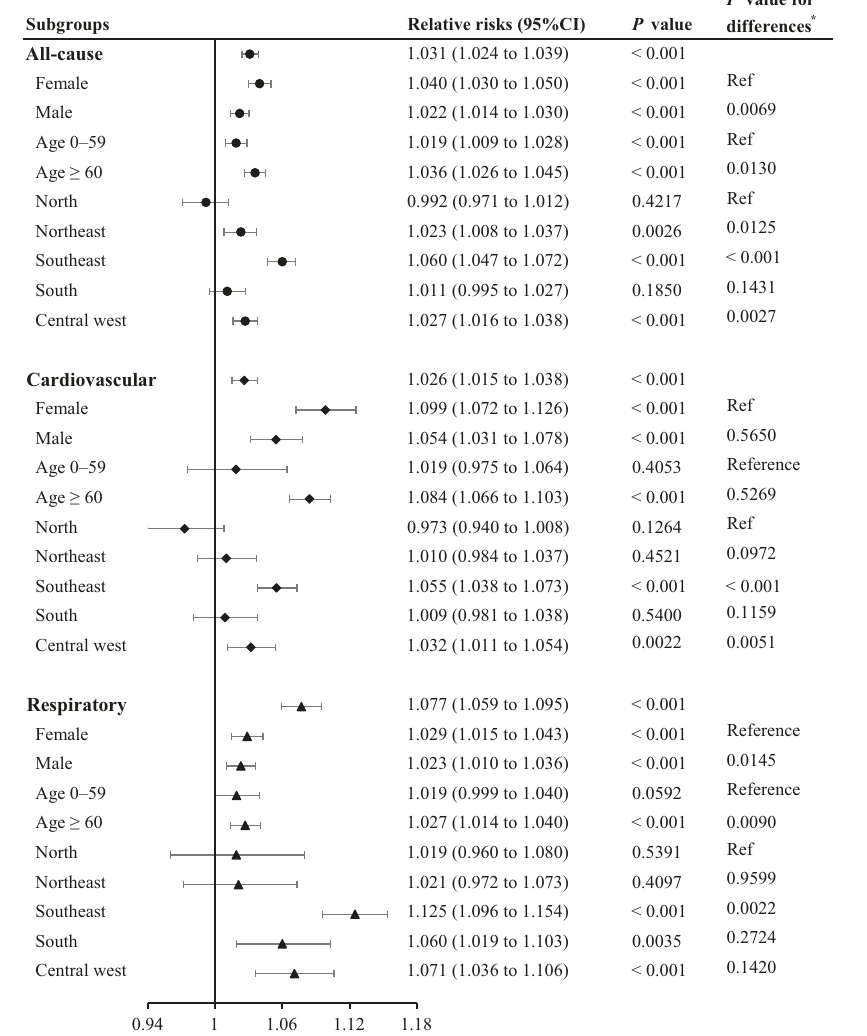
Fig. 3 | Pooled relative risks of all-cause, cardiovascular, and respiratory mor- tality (strati fi ed by sex and age groups) associated with a 10 µ g/m 3 increase in wild fi re-related PM 2.5 over lag 0 ‒ 14 days. (Note 1: * p value for the differences in cumulativerelativerisks(with95%CI)acrosspopulationsubgroupswereestimated by fi xed effect meta-regression. Note 2: black error bars correspond to 95%